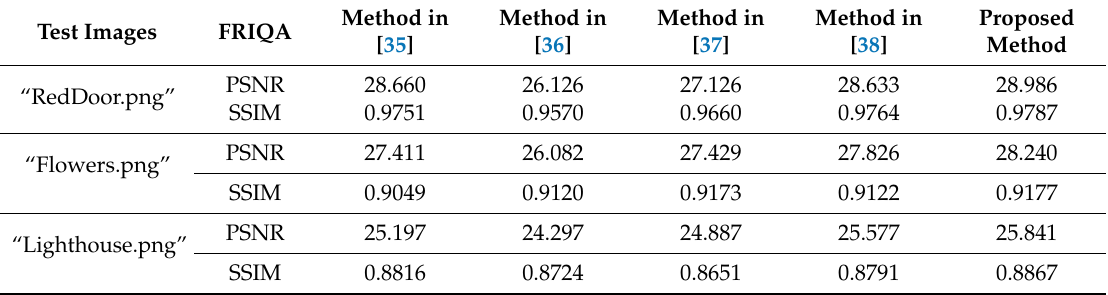
Table 2. Full-reference image quality assessment data of the comparison results of Figures 5–7.